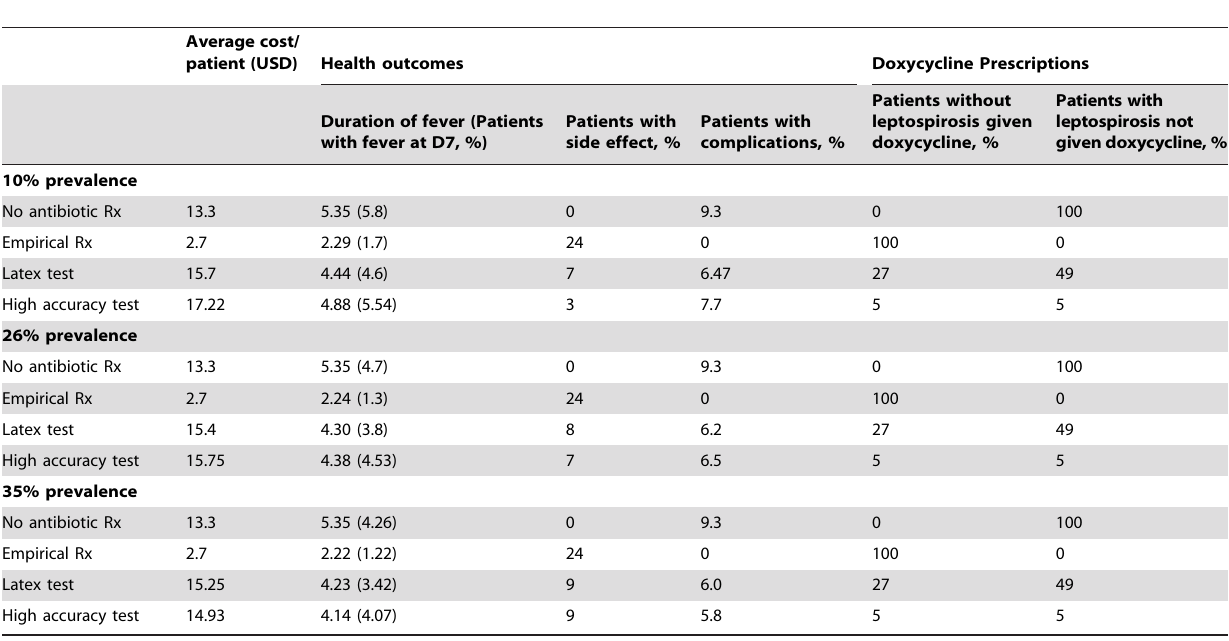
Table 5. Costs, clinical outcomes and antibiotic prescription at various prevalence rates and for patients receiving no treatment, empirical treatment, diagnosis using the latex test and diagnosis with a test with 95% sensitivity and specificity. Average cost/ patient (USD) Health outcomes Doxycycline Prescriptions Patients with Patients without leptospirosis not leptospirosis given Duration of fever (Patients Patients with Patients with givendoxycycline, % doxycycline, % with fever at D7, %) side effect, % complications, %